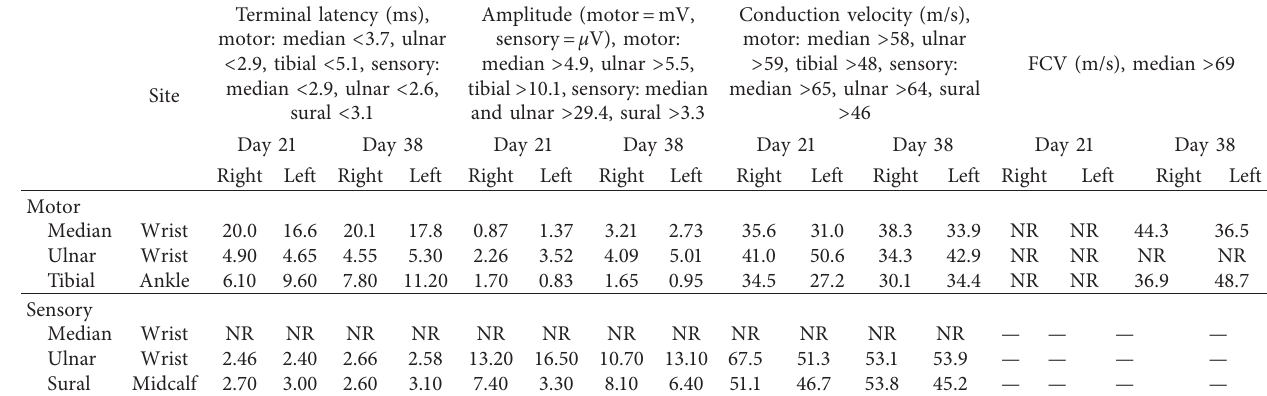
Table 1: Electrophysiological findings 21 and 38 days after spinal surgery.